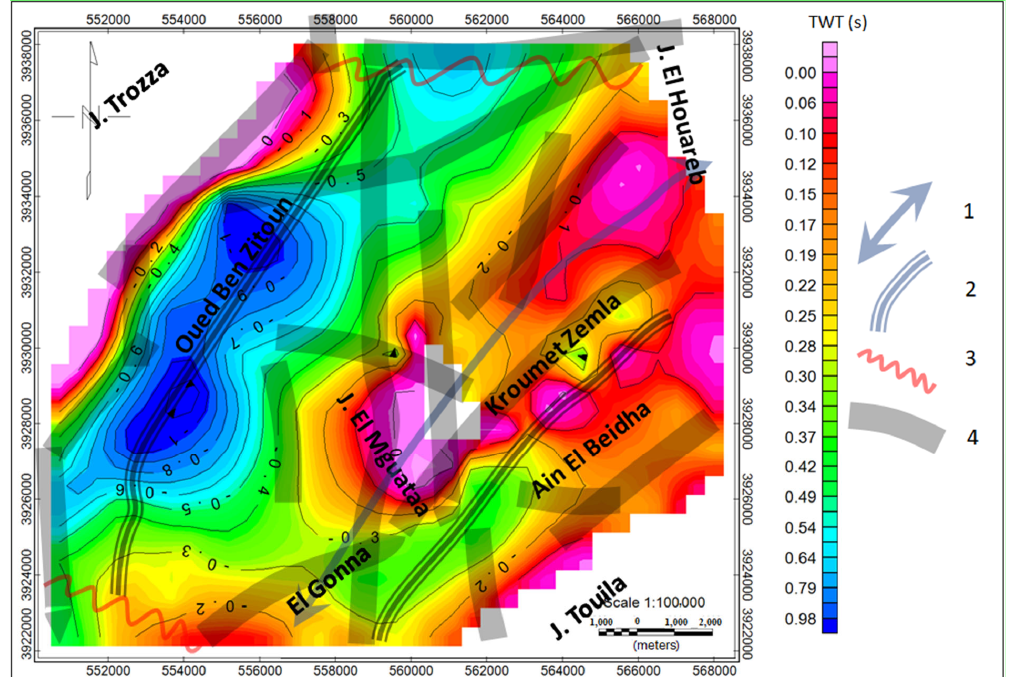
Figure 13. Isochron map of the top of the Eocene aquifer. (1) Major positive gravity anomaly axis. (3) Major negative gravity anomaly axis. (4) Northern and southern limits of the Ain El Beidha plain. (4) Major fault/discontinuity corridors.